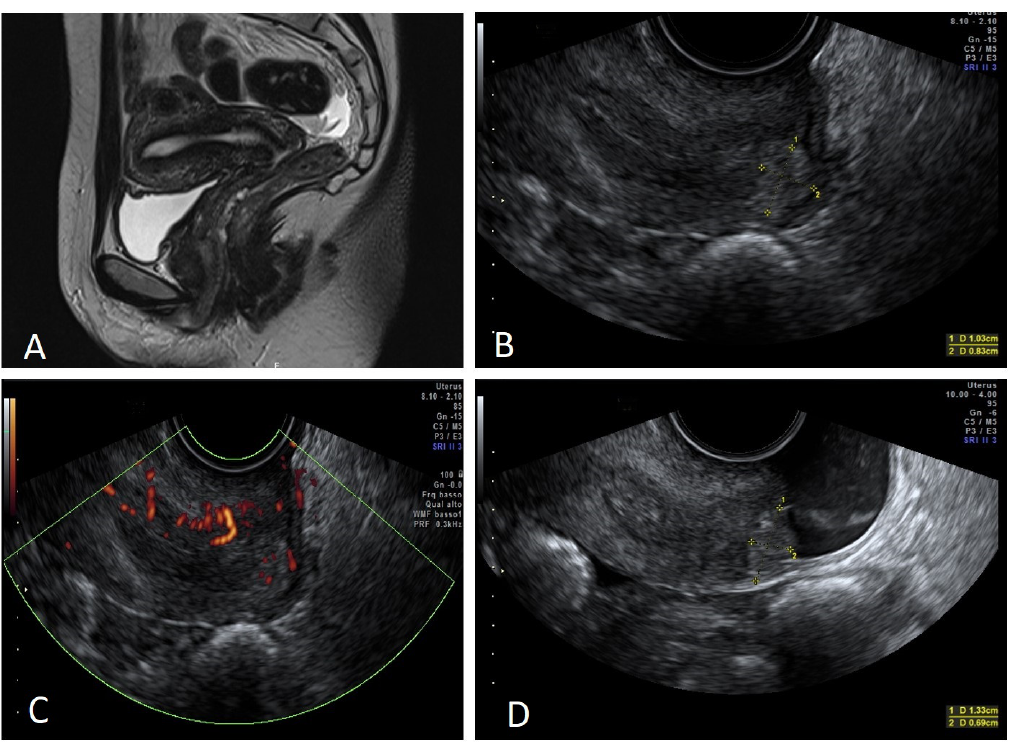
Figure 1. Small tumor after conization. ( A ) Not detectable disease by MRI. ( B ) Detectable disease by TVUS, measuring 10.3 × 8.3 mm. ( C ) Lesion vascularization by power Doppler. ( D ) Disease detectable by VGS, measuring 13.3 × 6.9 mm. Squamous tumors were predominantly hypoechoic (14/23; 60.1%), while adenocarci- nomas were mainly hyperechoic (16/23; 69.5%) ( p = 0.005). Figure 2 shows an example of two echogenicities, with and without VGS.